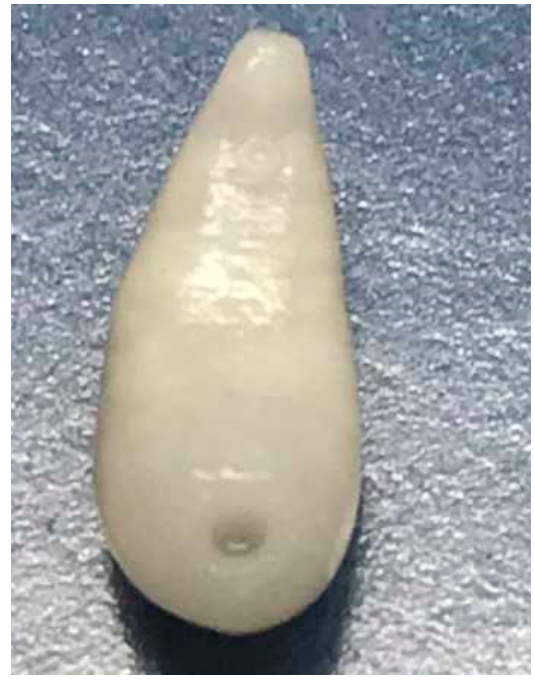
Figure 5. Adult Calicophoron daubneyi rumen fluke.